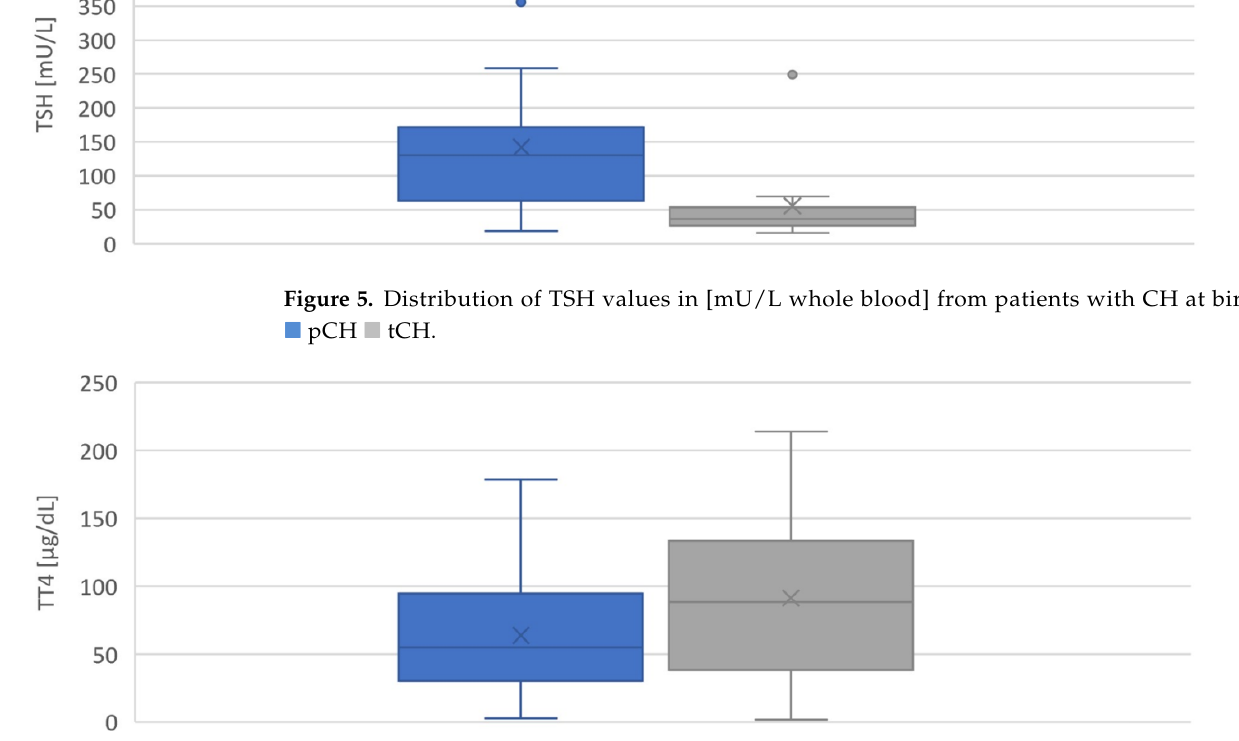
Figure 6. Distribution of TT4 values in [μg/dL whole blood] from patients with CH at birth. ■ pCH ■ tCH.